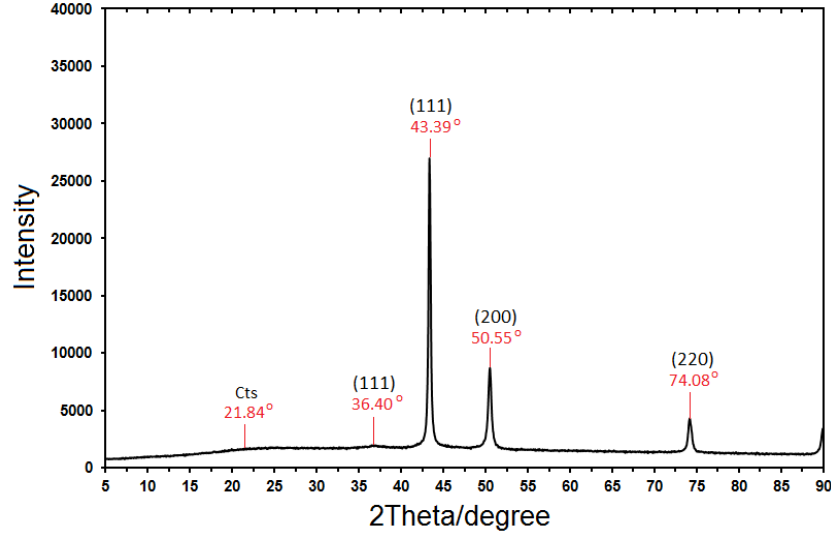
Figure 3. XRD Diffractogram of Cu-NPs synthesized in chitosan media.